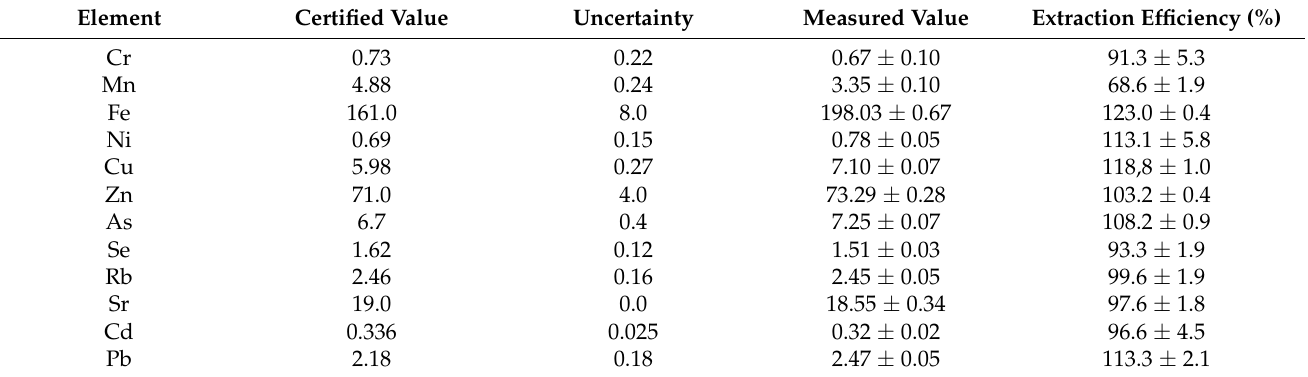
Table 2. Mussel (ERM-CE278k) certified and analysed elemental values, uncertainty (mg/kg) and calculated extraction efficiency (average ± standard deviation, N =